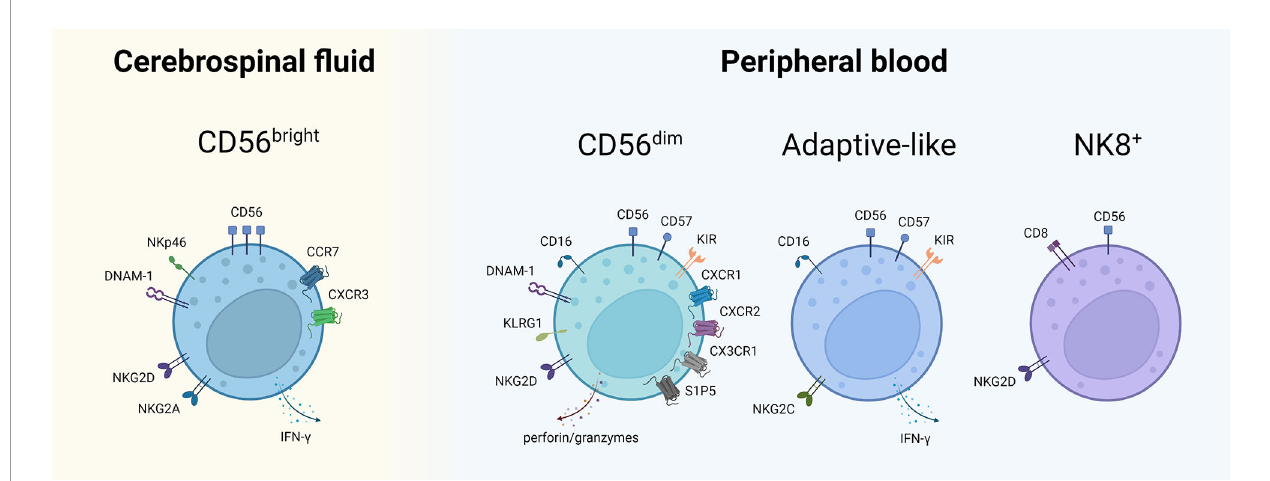
FIGURE 2 | NK cell subsets described in CSF and PB of MS patients. NK cell subsets with their characteristic cell surface markers described thus far in MS. The subsets are placed in the compartment where their putative role in MS has predominantly been described. Of note: the mentioned markers are non-exhaustive, the compartmentalization is not absolute and mutual exchange between CSF and PB is possible. NK, natural killer; CSF, cerebrospinal fl uid; PB, peripheral blood; NKT, natural killer T; CD, cluster of differentiation; DNAM-1, DNAX accessory molecule 1; IFN, interferon; CCR, CC-chemokine receptor; CXC, chemokine receptor; KLRG1, killer cell lectin-like receptor G1; KIR, killer immunoglobulin-like receptor; S1P5, sphingosine-1-phosphate receptor 5; NK8 + , CD8 + natural killer cell. Created with